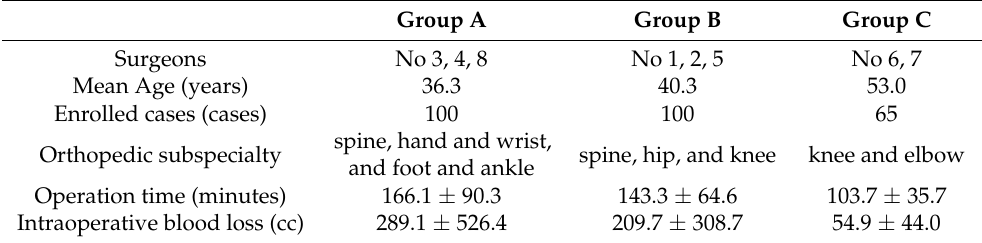
Table 2. Characteristics of groups classified into experience in orthopedic subspeciality. Group